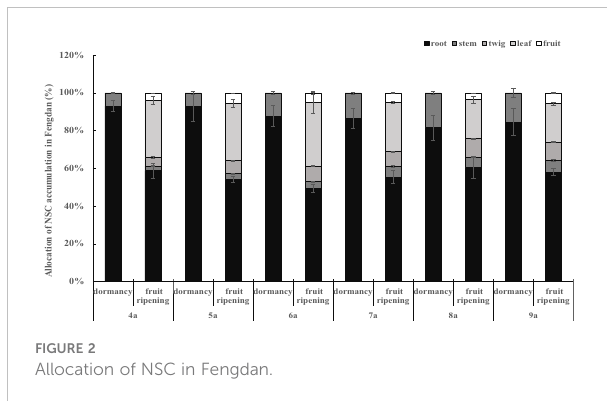
FIGURE 2 Allocation of NSC in Fengdan.